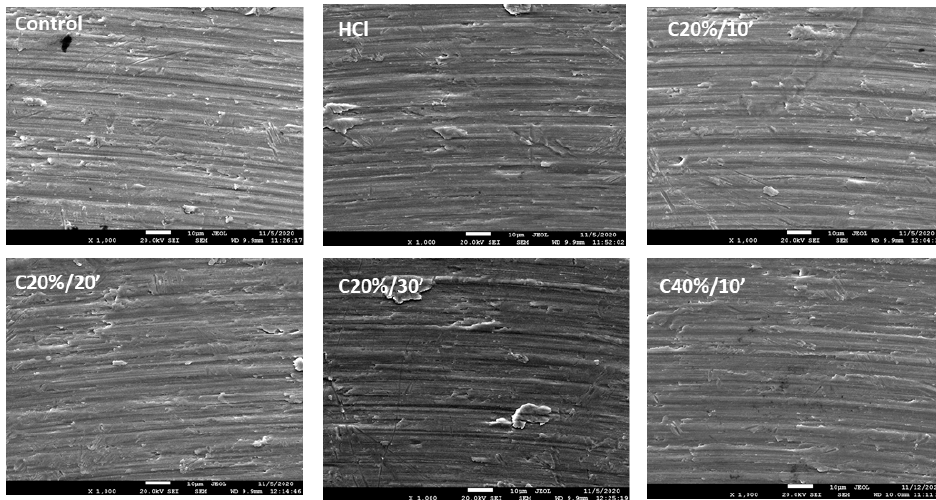
Figure 2. Surfaces of the cpTi treated with different passivation conditions.